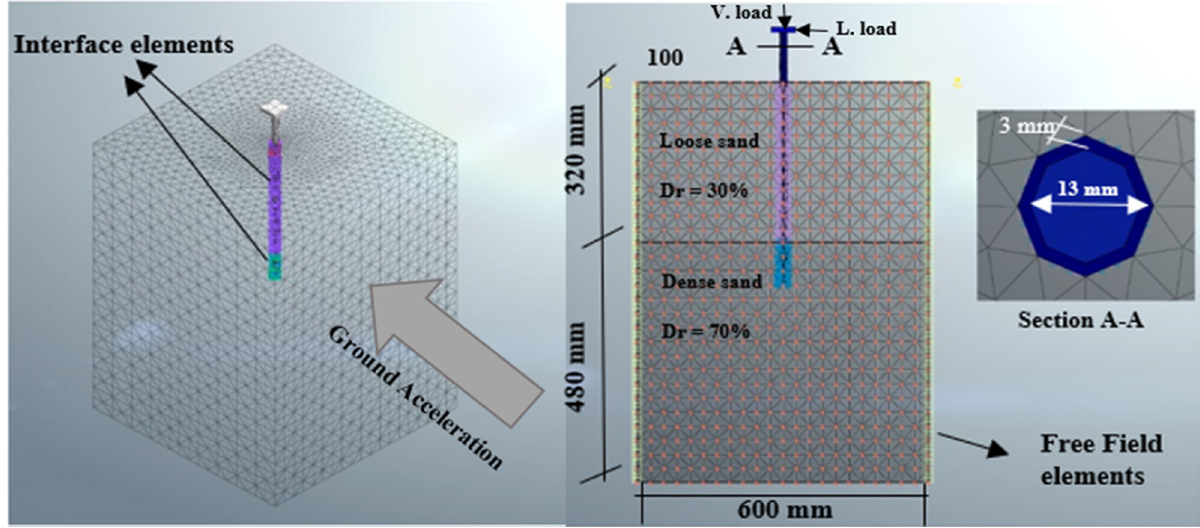
Figure 1: 3D fi nite element model implemented in the current study.